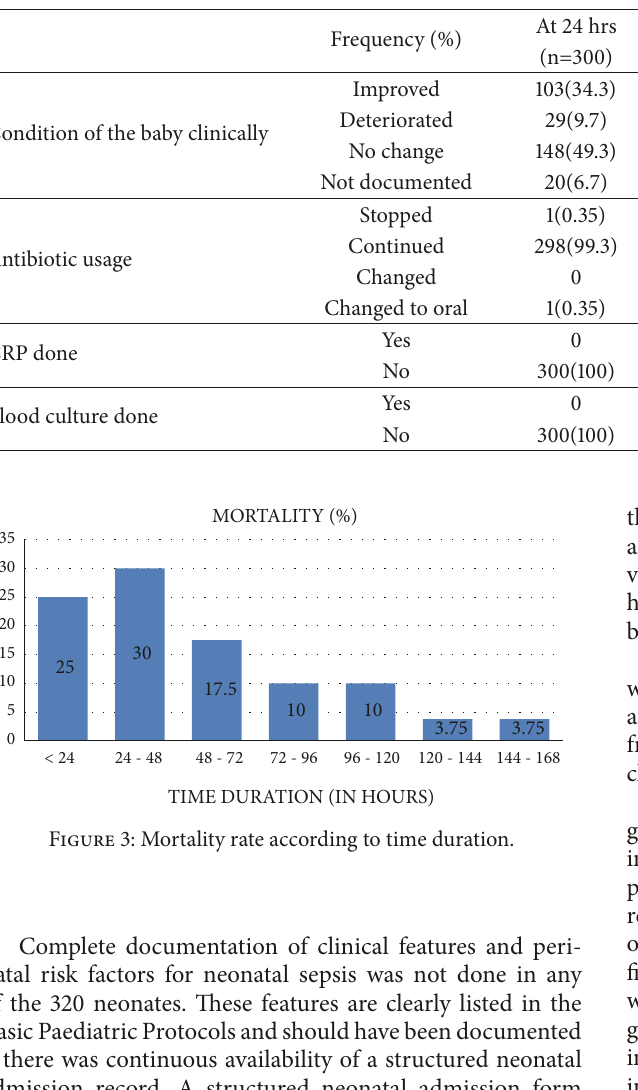
Table 5: Audit of antibiotic usage over 5 days.